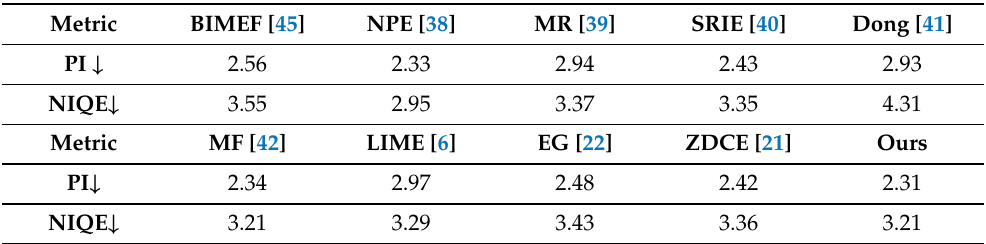
Table 1. Quantitative results in the RCL dataset. MR (MultiscaleRetinex) EG (EnlightenGAN) ZDCE